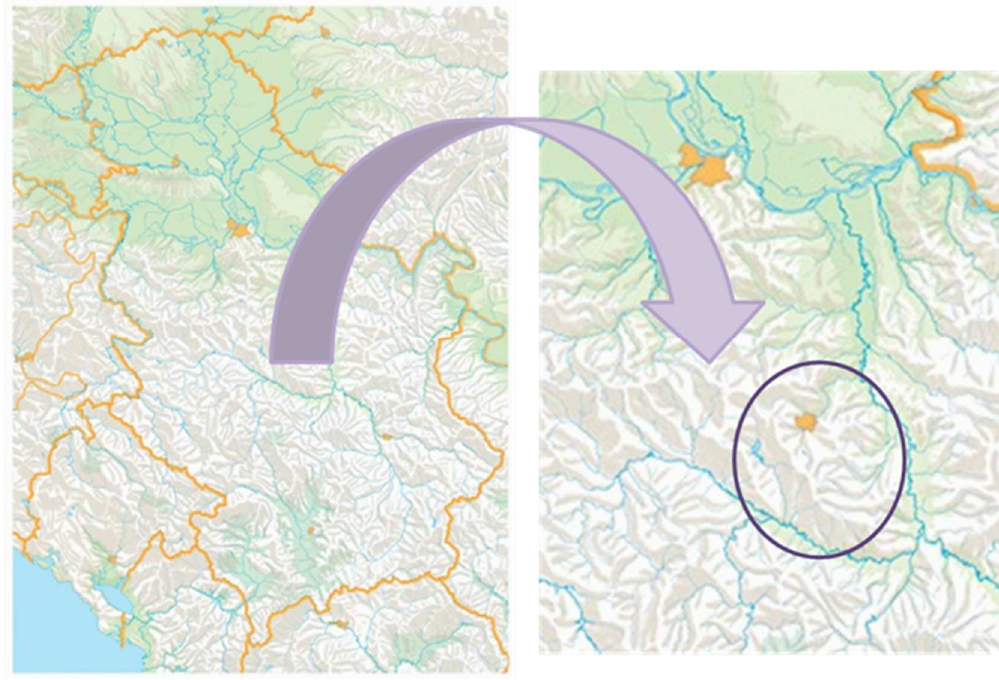
Figure 1. Study area: Kragujevac